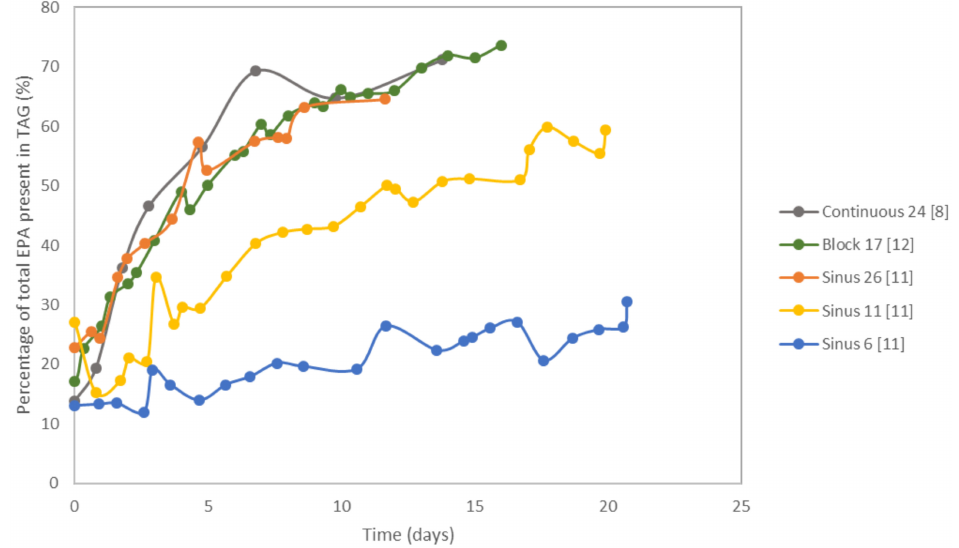
Figure A4. The percentage of all EPA in the cell, which is present in TAG lipid fraction for the different biomass-specific photon supply rates and light regimes